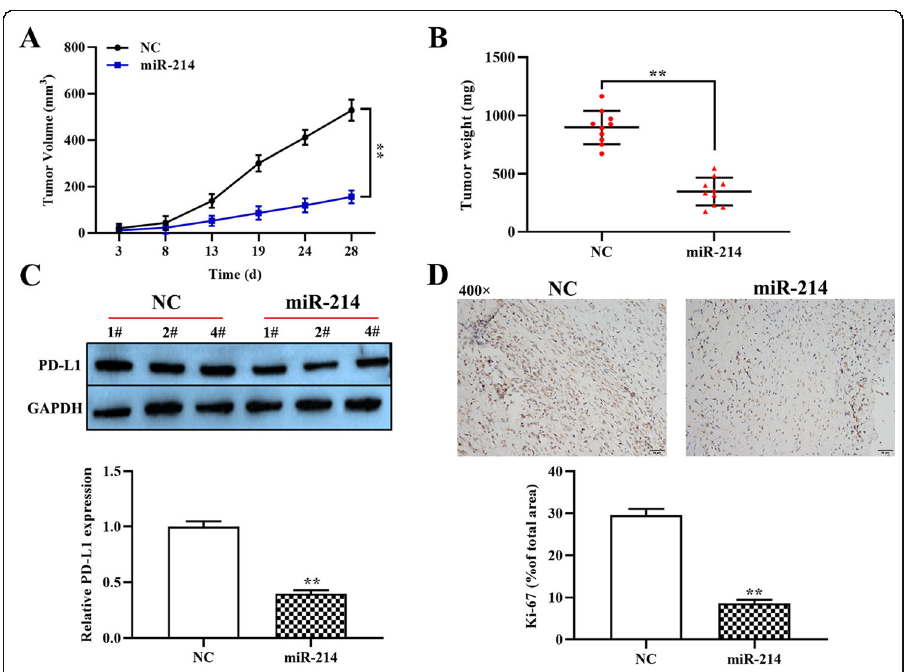
Fig. 5 Effect of miR-214 overexpression on the progression of DLBCL in vivo. ( a ) The tumor volume curve of nude mice treated with miR-214 or NC was analyzed. ( b ) The tumor weight was measured in the transfected miR-214 or NC group. ( c ) The expression of PD-L1 protein in the tumor tissues was measured using western blot. ( d ) The expression of Ki-67 was determined in tumor tissues using immunohistochemistry (magnification, × 400). *p < 0.05, **p < 0.01, compared with the NC